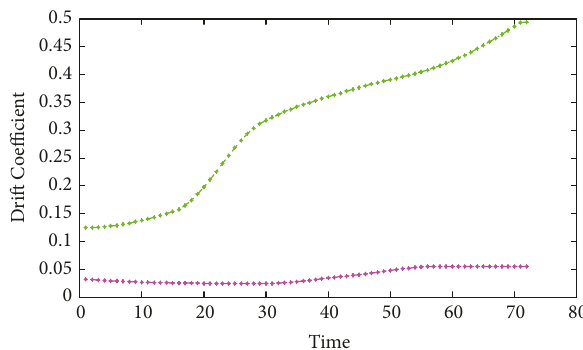
Figure 2: Degradation of the drift coefficient of